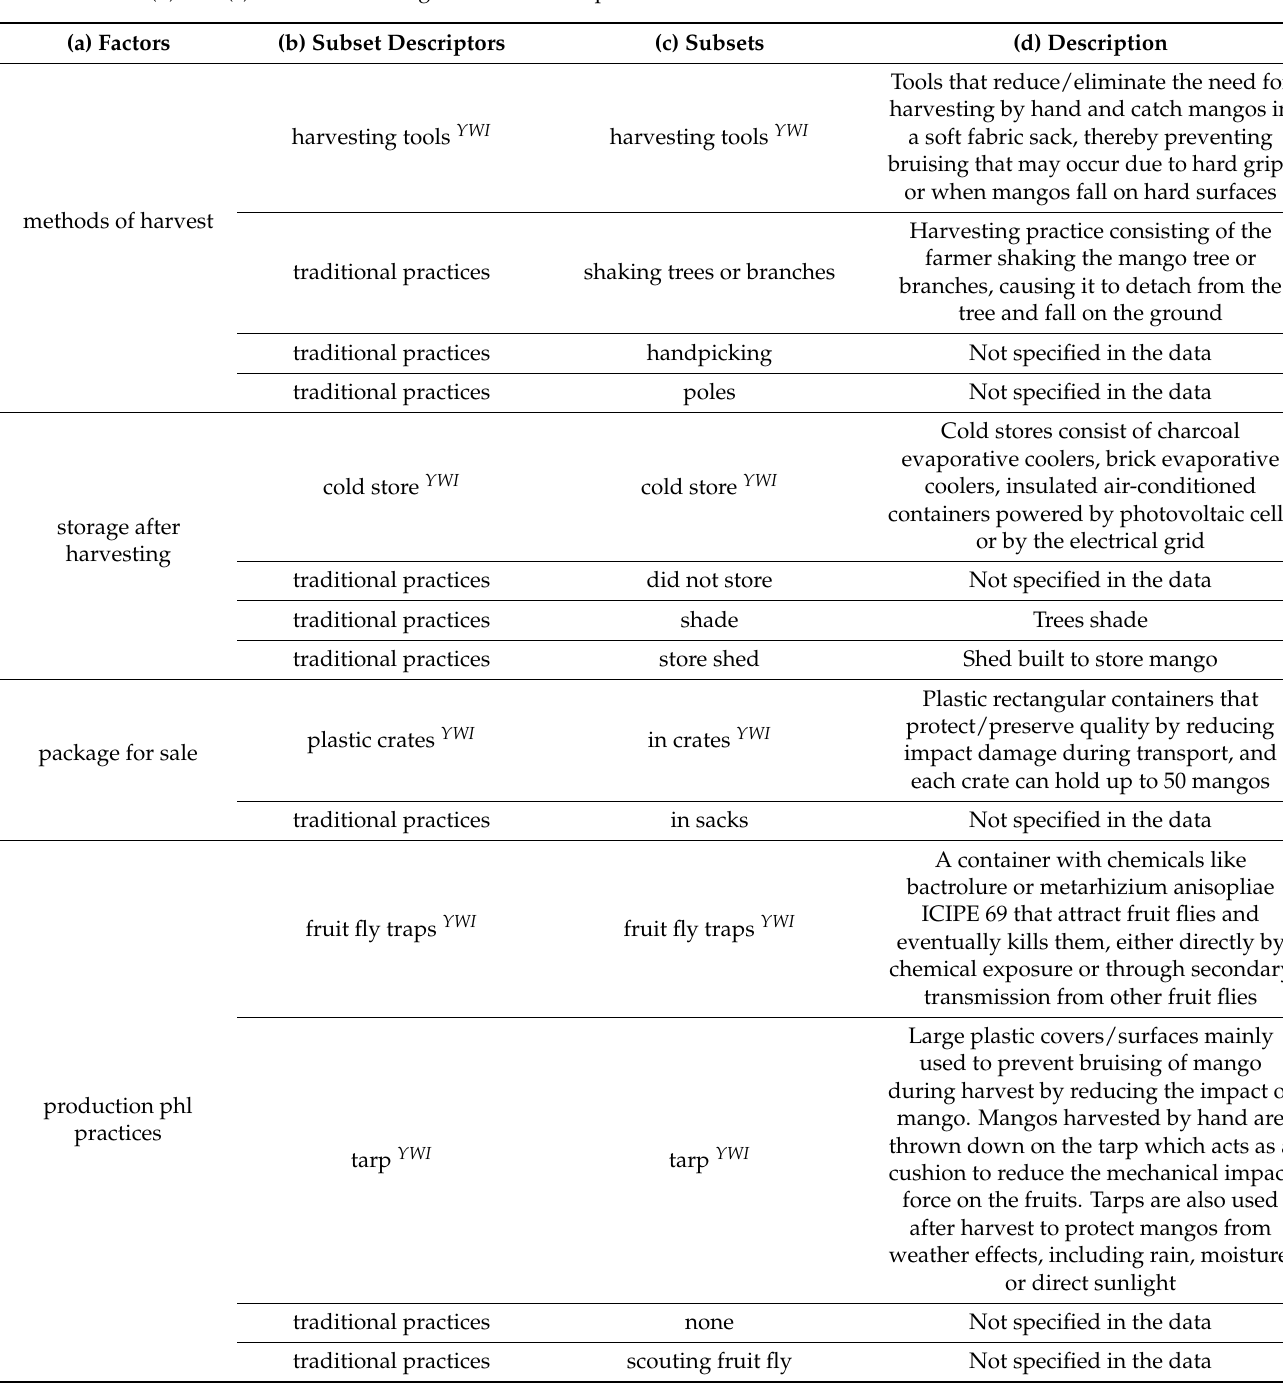
Table 2. Summarizing and describing factors containing postharvest technology subsets: Column (a) shows the four factors containing postharvest technologies. Column (b) shows the subset descriptors, which are renamed subsets; these were determined to reduce the raw data into fewer categories, to facilitate subsequent analysis. Column (c) shows the subsets of each factor as initially recorded in the raw data. Column (d) describes the purpose of each subset. The superscripts YWI in Columns (b) and (c) refer to technologies that the YWI